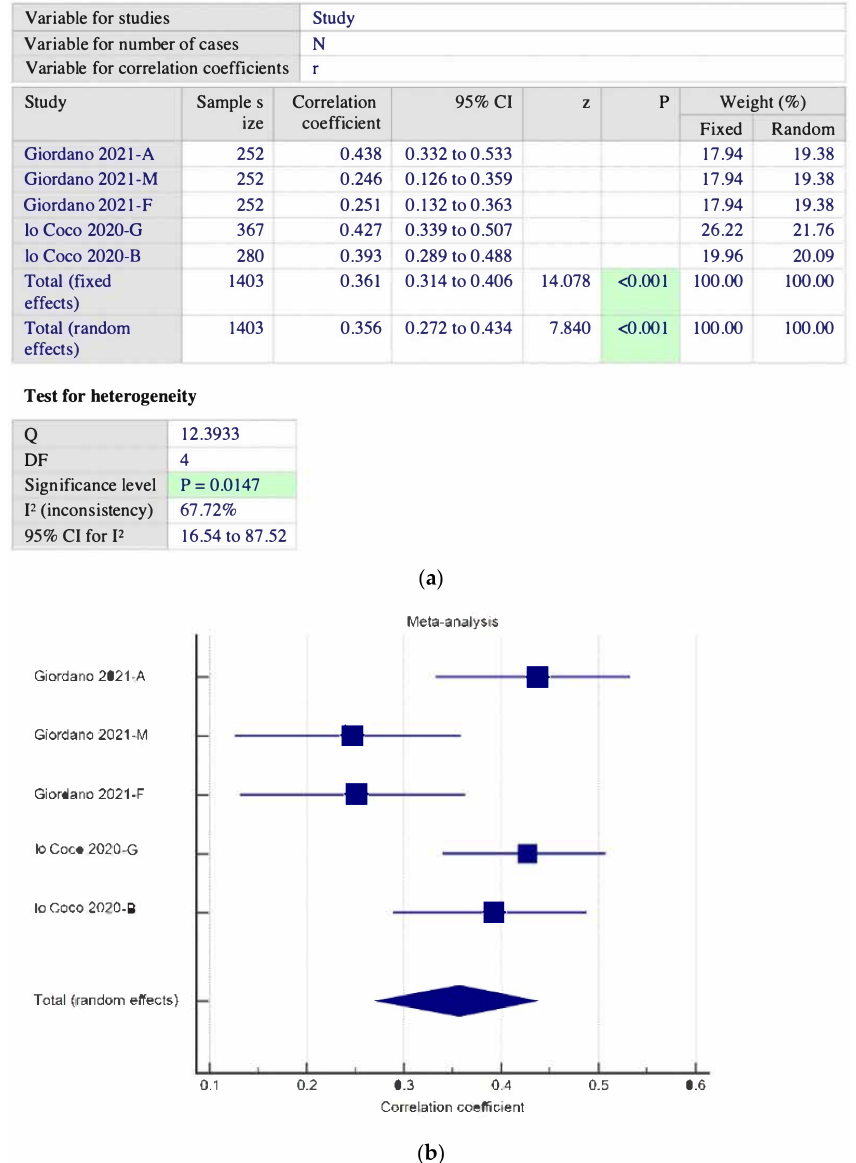
Figure 3. ( a ) Meta-analysis on DERS-SF—SPAI subgroup [49,50]; ( b ) forest plot showing the relation- ship between emotional dysregulation and PSU in studies using DERS-SF and SPAI scales